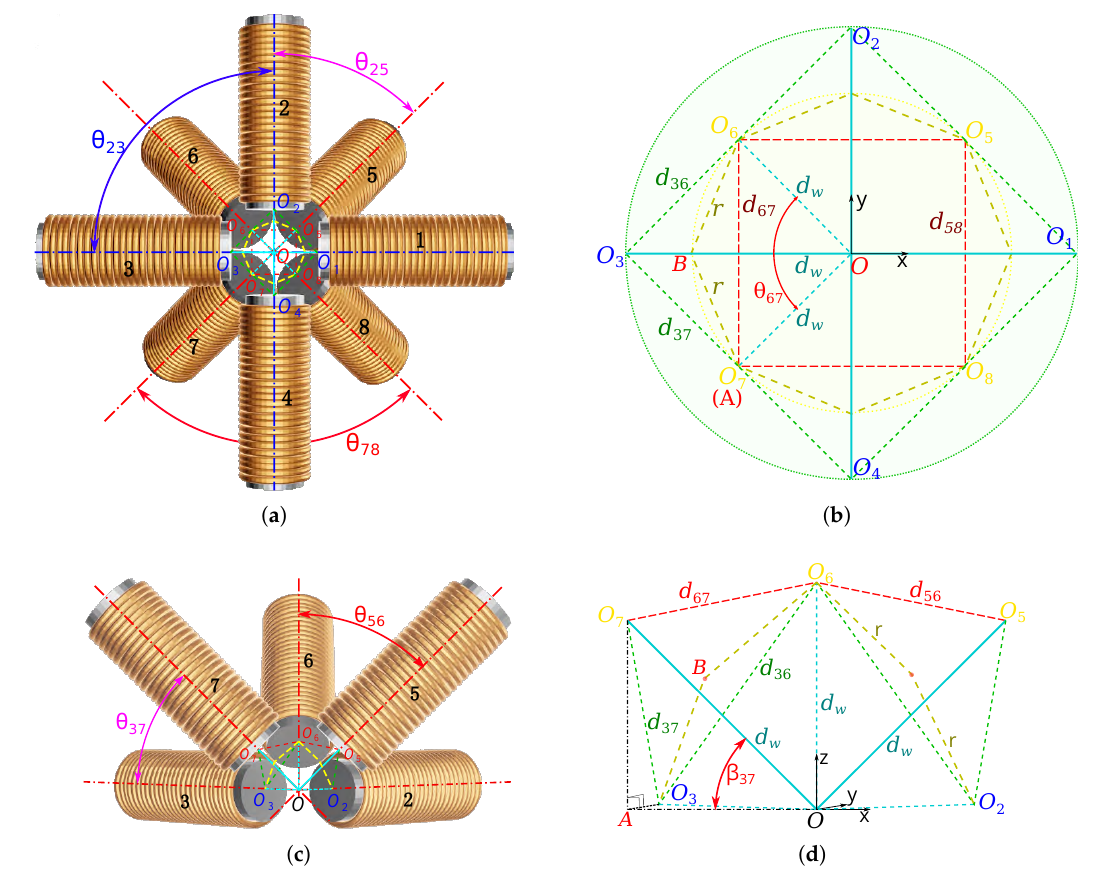
Figure 6. Representation of the geometric arrangement of the 3D n = 8 electromagnetic coils: ( a ) top views; ( c ) side views where three electromagnetic coils are removed to show clearly internal space; ( b , d ) the geometry between the electromagnets’ center O e . The plain lines depict the in-plane lengths, whereas dashed lines represent the out-of-plane ones.